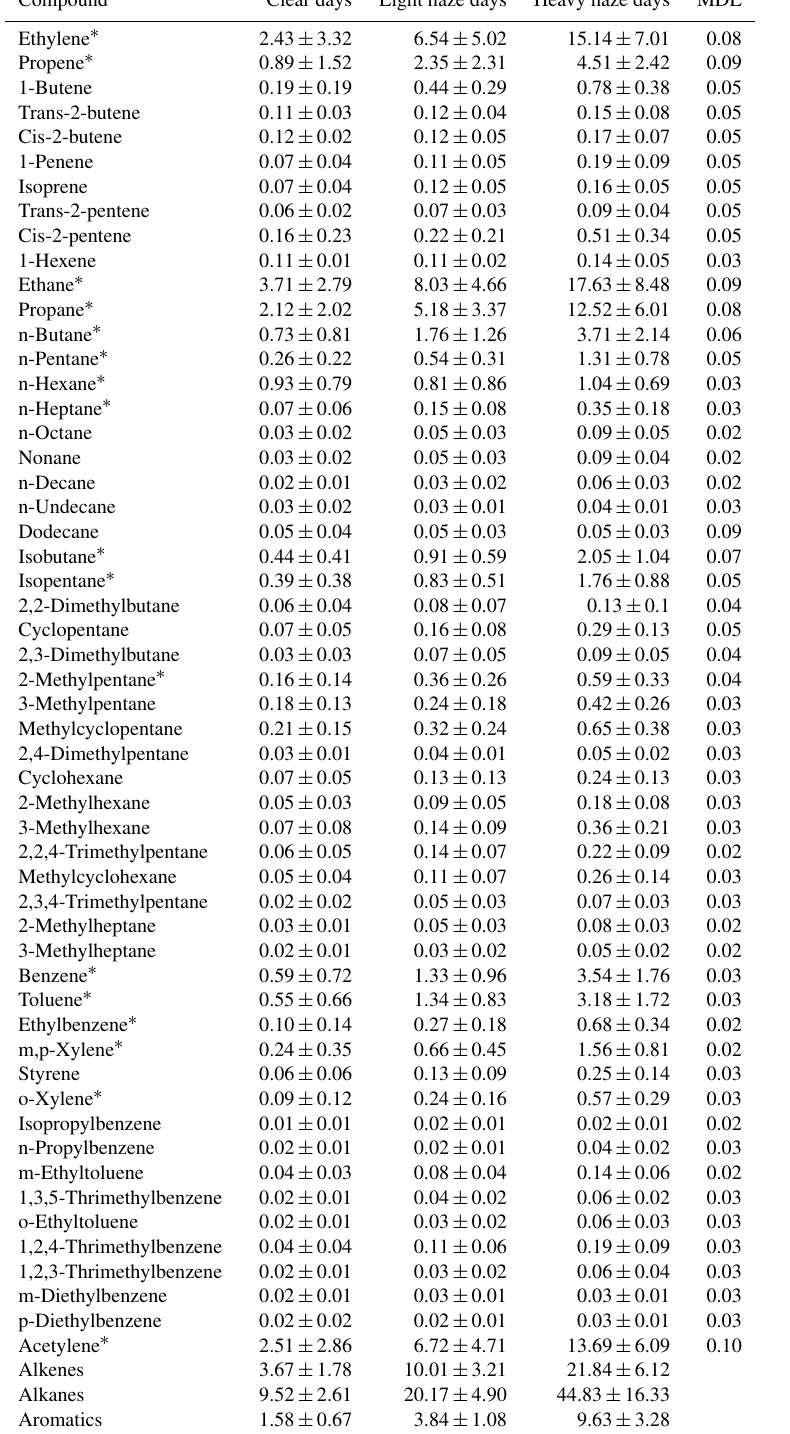
Table 2. The method detection limit (MDL), mean concentrations, and standard deviations of NMHCs during clear days, light haze days, and heavy haze days